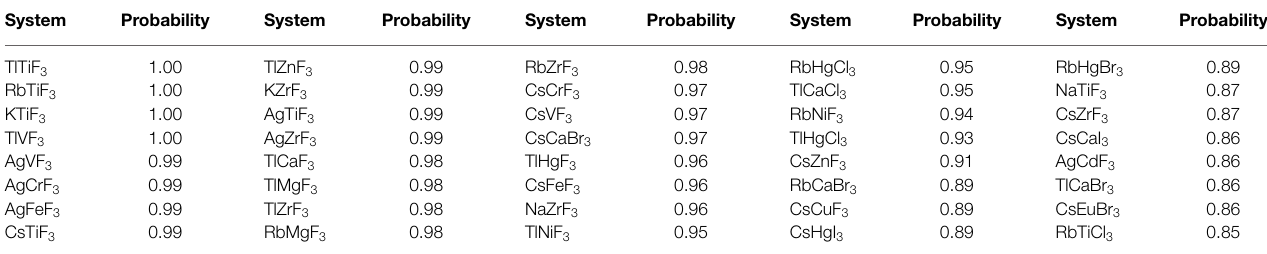
TABLE 3 | Model predicted novel ABX 3 chemistries with a probability of (cid:21) 85% to form a perovskite structure . System Probability System Probability System Probability System Probability System